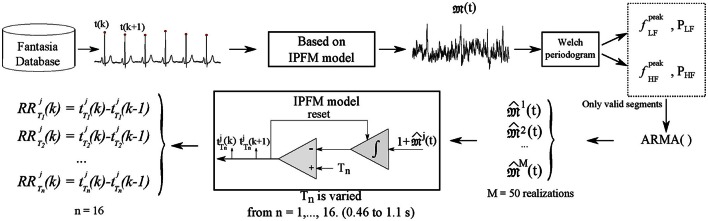
Simulation data scheme is illustrated. Heartbeat time occurrences are detected from ECG. Based on the IPFM model the ANS modulating signal 𝔐(t) is estimated. Spectral analysis by Welch periodogram is computed on (t) in order to estimate the parameters needed for the simulation, frequency and power of LF and HF components, which are used to construct a new set of modulating signals,
j(t), through ARMA technique, with M = 50 realizations. Then, IPFM model is used to generate simulated heartbeat occurrences t Tnj(k) with different values of T from 0.46 to 1.1 s. Simulated RR series are computed from the t Tnj(k).